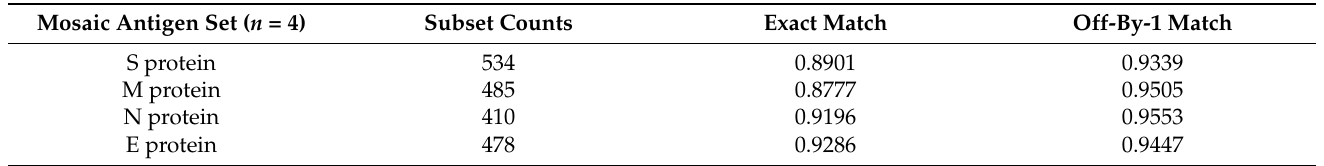
Table 4. The mean epitope-coverage over the circulating viral proteins sequences covered by the CTL epitope in mosaic